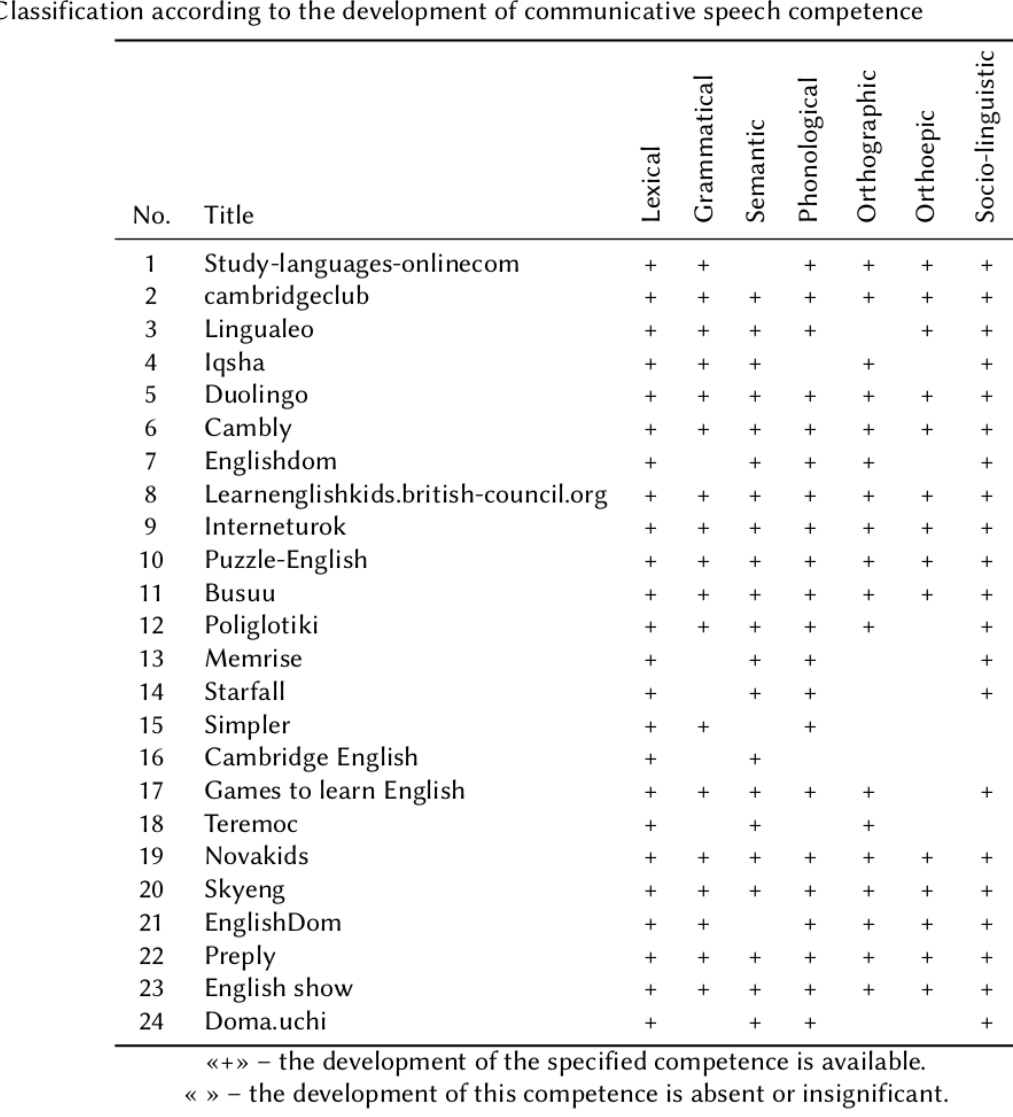
Figure 87: Presentation of paper